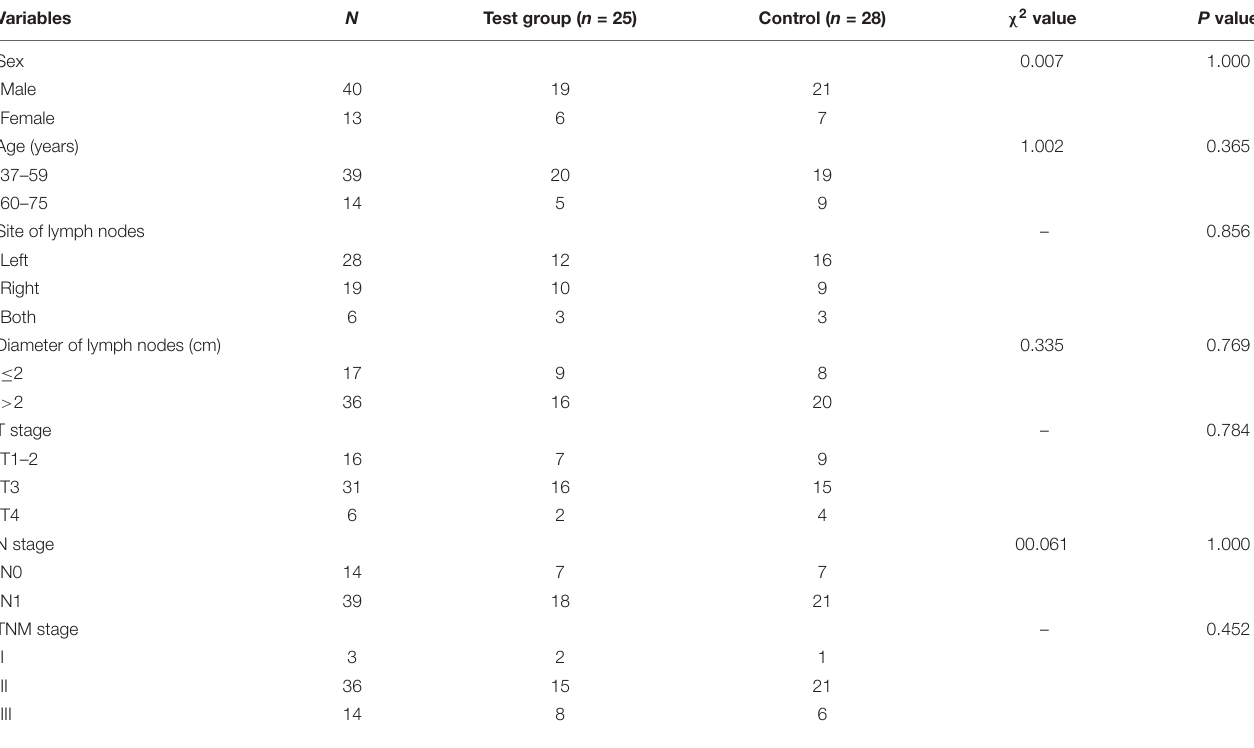
TABLE 1 | Patients’